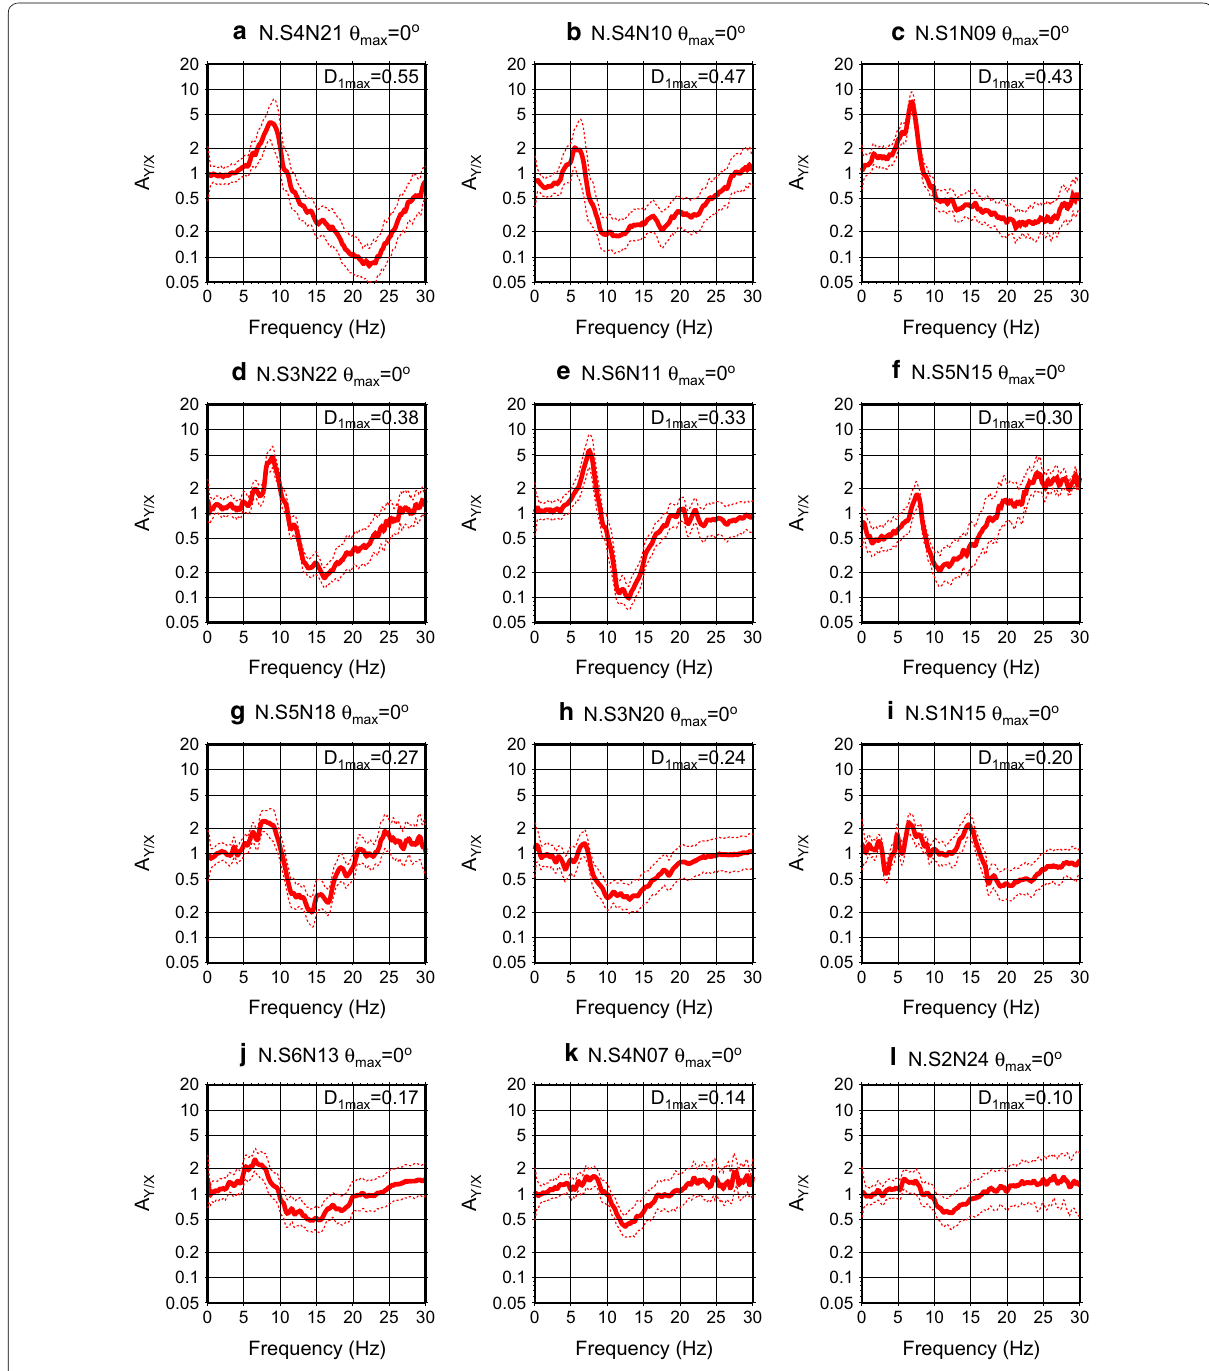
Fig. 7 Average Y/X amplitude spectral ratio (solid red curves) and logarithmic standard deviation (dotted red curves) at θ selected S-net stations with different D 1max , amongst those installed at water depths deeper than 1500 m. The θ max and D 1max values for each station are written at the top and inside of each subfigure,